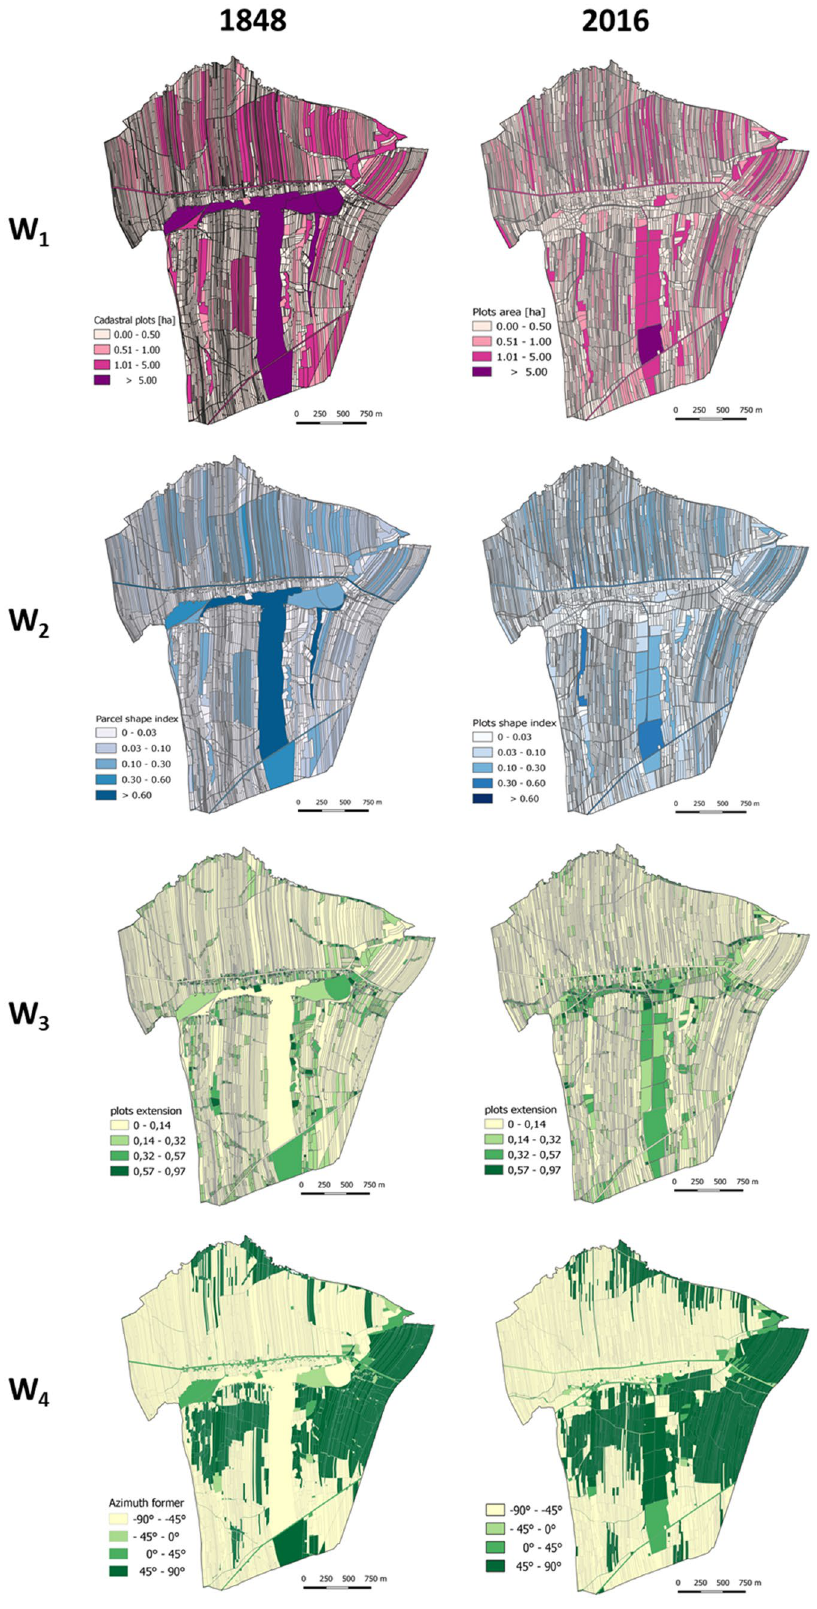
Figure 5. Spatial distribution of component